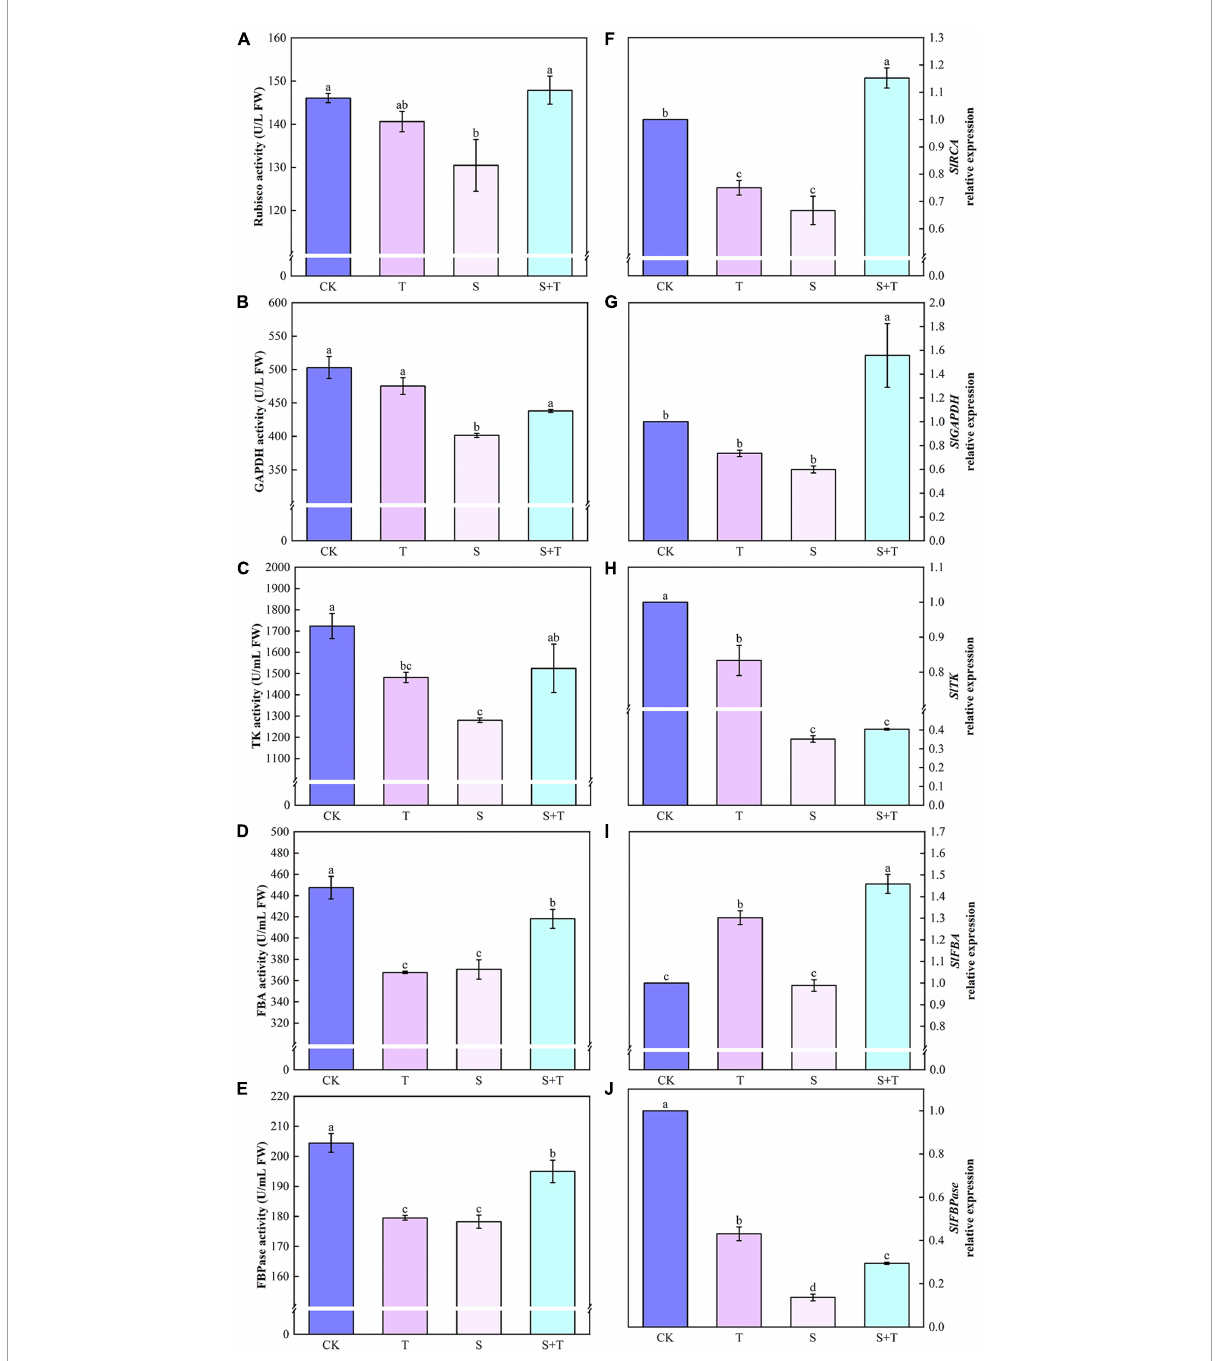
FIGURE2 Effects of Tre treatment on Calvin cycle key enzymes and genes of tomato seedlings exposed to salt stress for 5 days. Panels (A–E) represent the activity of Rubisco, GAPDH, TK, FBA and FBPase, respectively. Panels (F–J) represent the expression levels of SlRCA , SlGAPDH , SlTK , SlFBA , and SlFBPase , respectively. The results showed the mean ± SE of three replicates, and the different letters denote the significant difference among treatments ( P < 0.05), according to Duncan’s multiple tests. CK, control; T, 10 mM Tre; S, 150 mM NaCl; S+T, 150 mM NaCl + 10mM